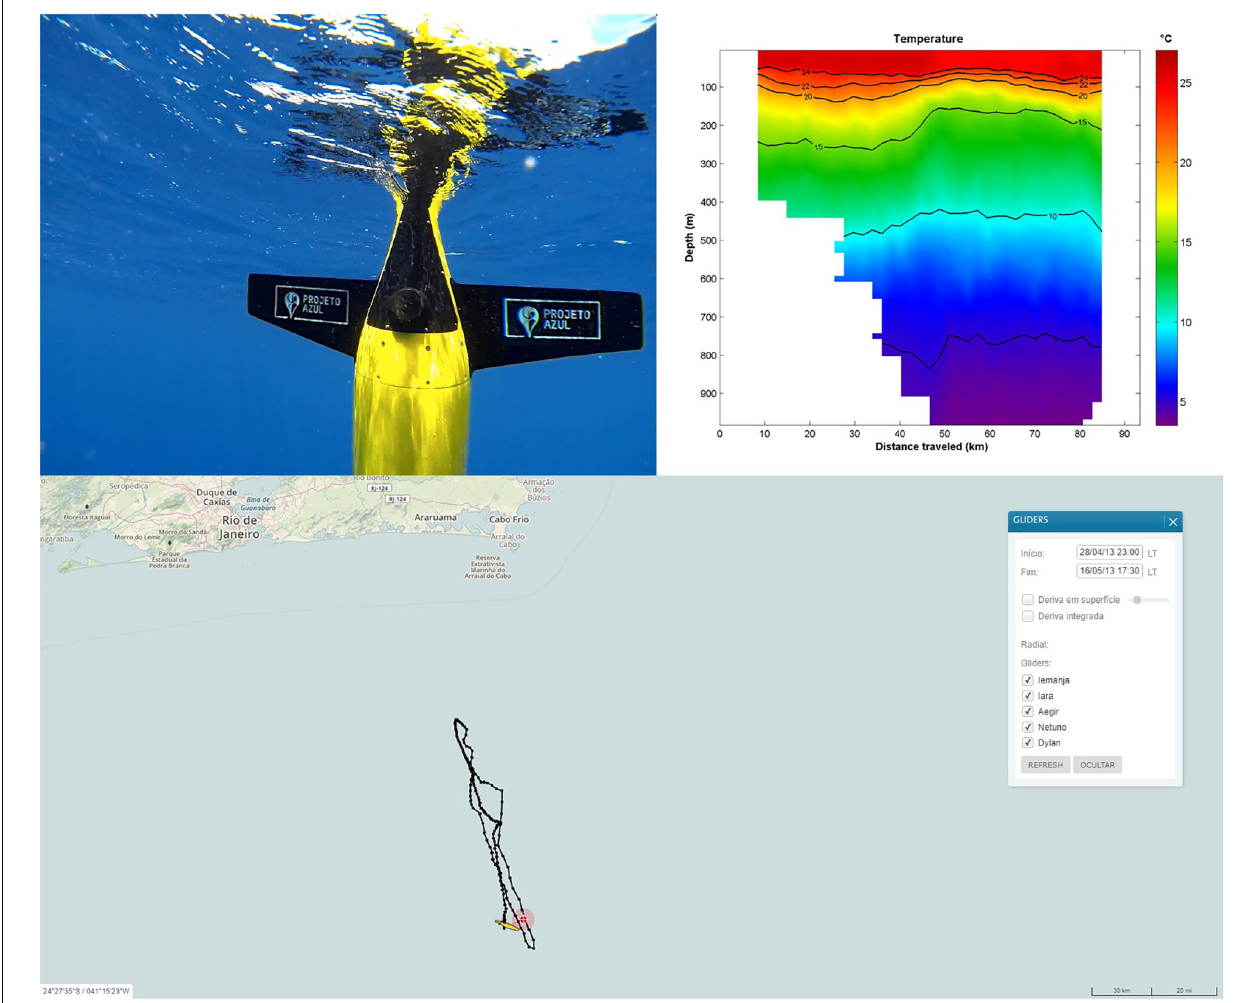
FIGURE 7 | The glider used in project AZUL, the position of a monitored section lower right side and a temperature vertical section generated by the acquired data.